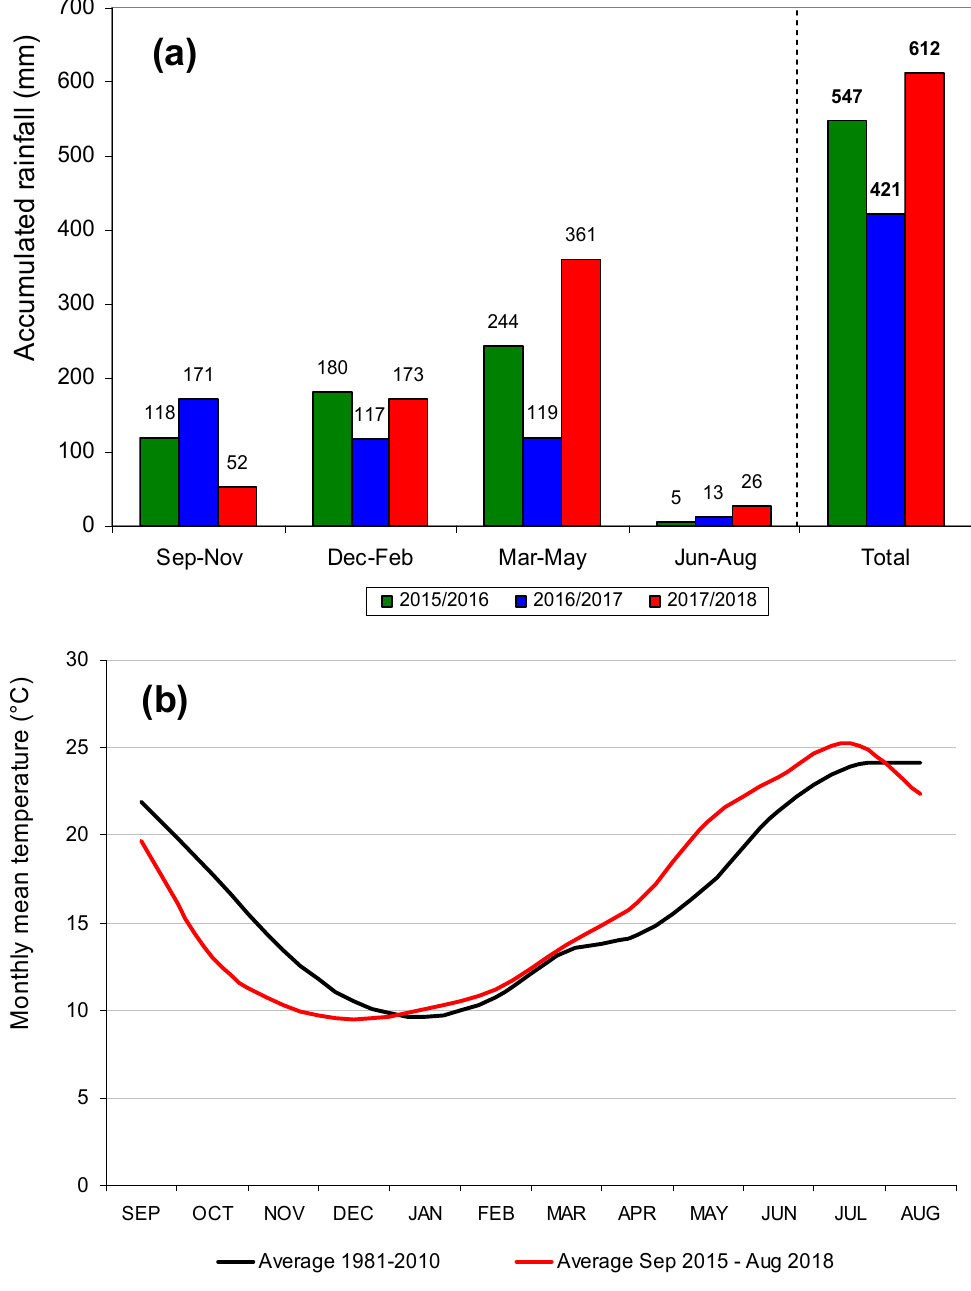
Figure 5. Accumulated rainfall (by trimester and total) in the agricultural years of